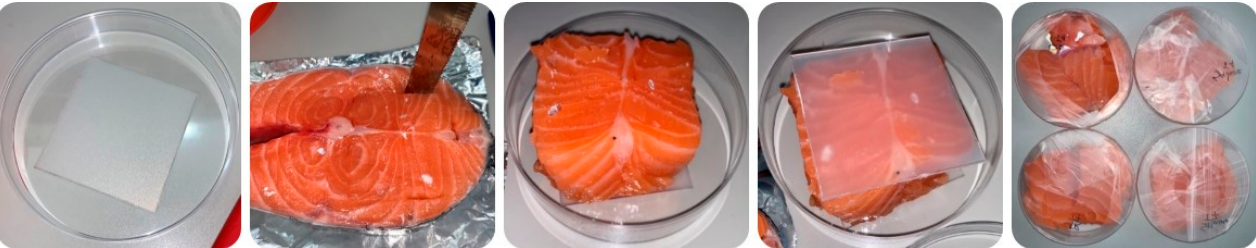
Figure 2. Representative scheme of the experimental preparation of salmon fillets.